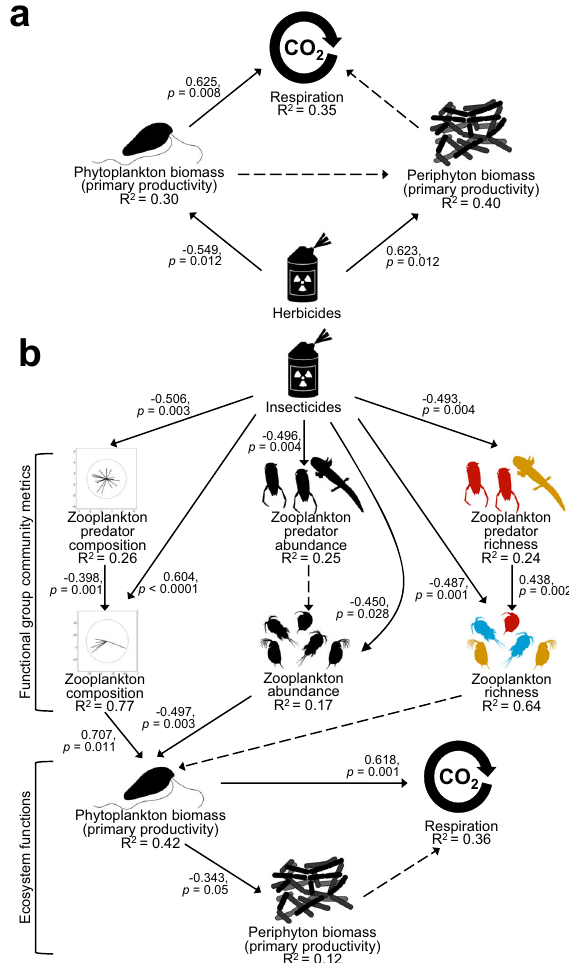
Fig. 4 Structural equation models linking pesticides-induced changes in composition, abundance, and richness of functional groups to ecosystem functions. a Through bottom-up effects, herbicide exposure decreases respiration through decreases in the abundance of phytoplankton. b The effects of insecticides on respiration and primary production of phytoplankton are driven by top-down effects on zooplankton composition and abundance, but not richness. Solid arrows are signi fi cant paths, and dotted arrows are non-signi fi cant paths. P -values, standardized coef fi cients, and conditional R 2 values are provided. In b , the residuals of zooplankton composition, abundance, and richness covary, and the residuals of zooplankton predator composition, abundance, and richness covary. In both structural equation models, individual paths were linear models. Individual path P -values were based two-sided t-tests. The data fi t the models well ( a : Fisher ’ s C = 3.601 with P -value = 0.165 on 2 degrees of freedom, b : Fisher ’ s C = 53.176 with P -value = 0.282 on 48 degrees of freedom). Attribution of silhouette: periphyton (created by Matt Crook, license link, image has been